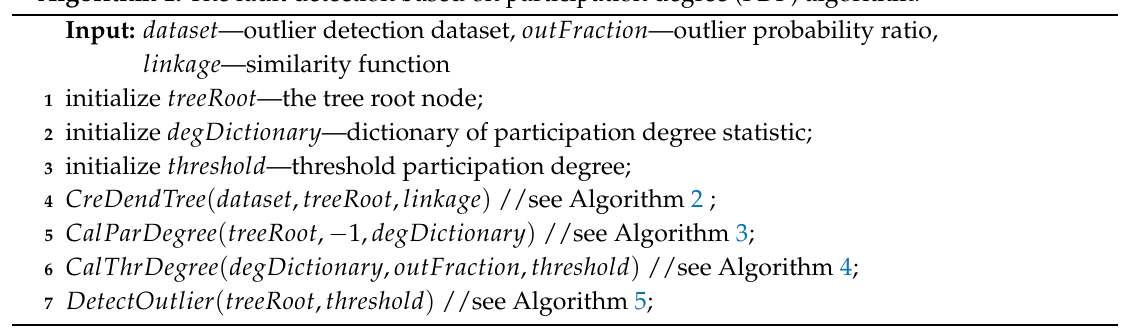
Algorithm 1: The fault detection based on participation degree (FDP) algorithm.